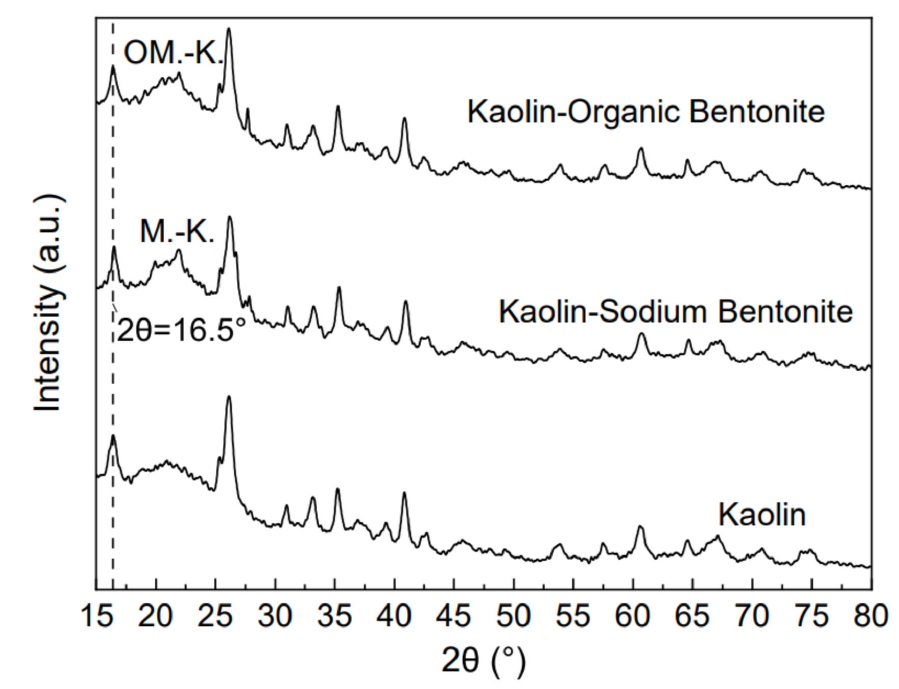
Figure 2. XRD patterns of the three